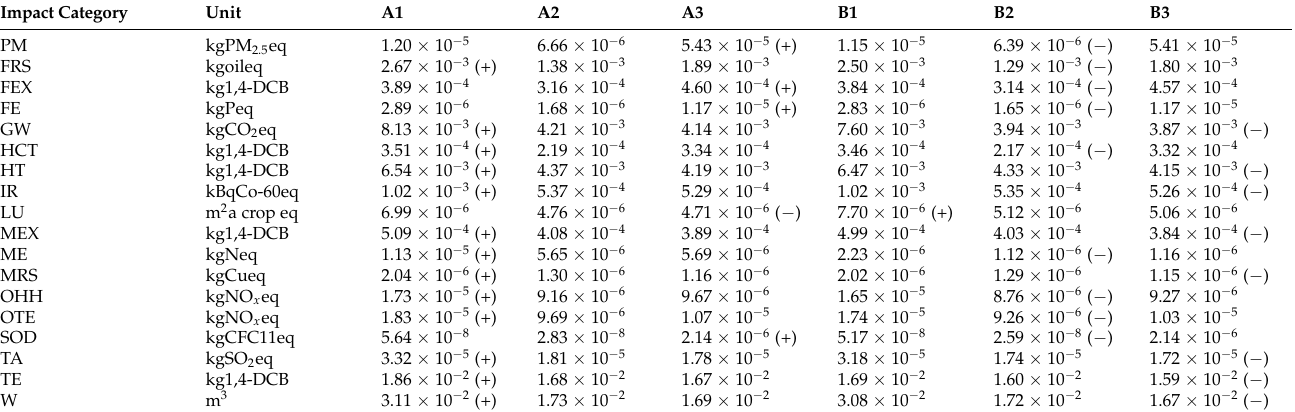
Table 16. LCA results of the six scenarios performed across the impact categories. symbol (+) shows the highest value compared to the other scenarios; symbol ( − ) shows the lowest value compared to other scenarios. The visualization shows A1 has the highest results for almost all categories, and B2 and B3 have the lowest values in several impact